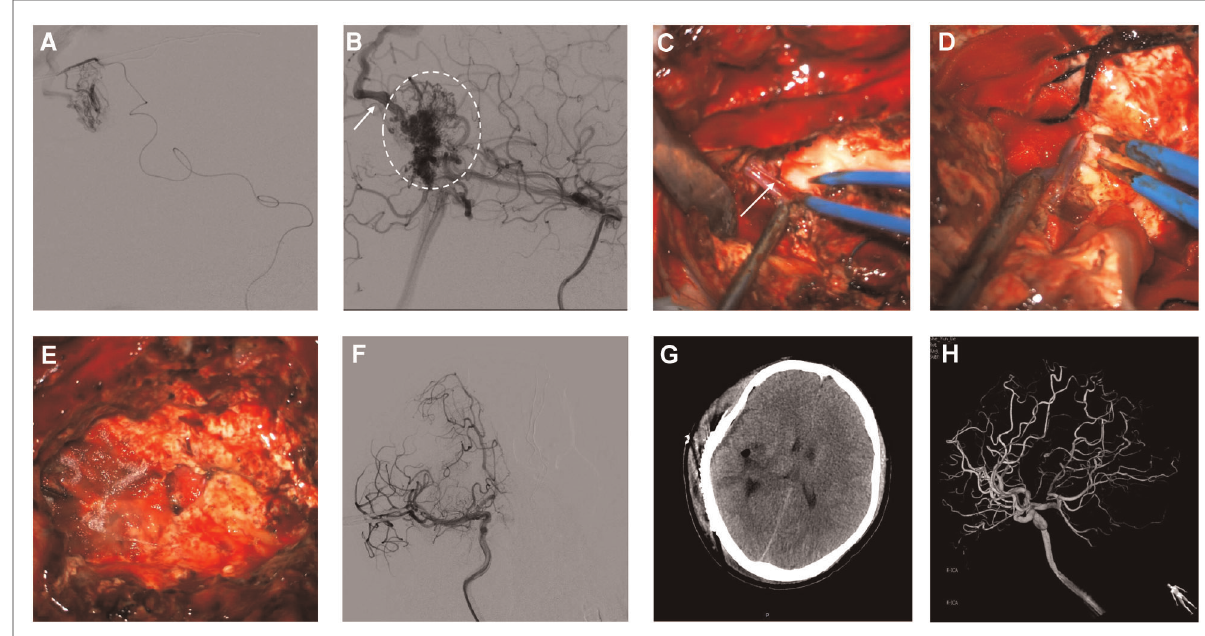
FIGURE 2 Intraoperative angiography demonstrates subsequent injection of Onyx18 with obliteration of the AVM ( A ). Lateral view of right ICA angiogram demonstrates the presence of residual arteriovenous malformation (dashed oval) with an early draining vein (arrow) ( B ). The feeding artery arteries and main draining veins were isolated and resected ( C,D , arrows). Intra-operative image shows lesion excised during surgery ( E ). Postoperative anteroposterior projection angiograms following resection demonstrate the obliteration of the AVM ( F ). Postoperative Contrast CT shows no obvious signi fi cant ischemic or hemorrhage changes ( G ). Follow-up 3D DSA shows the complete disappearance of AVM ( H ).